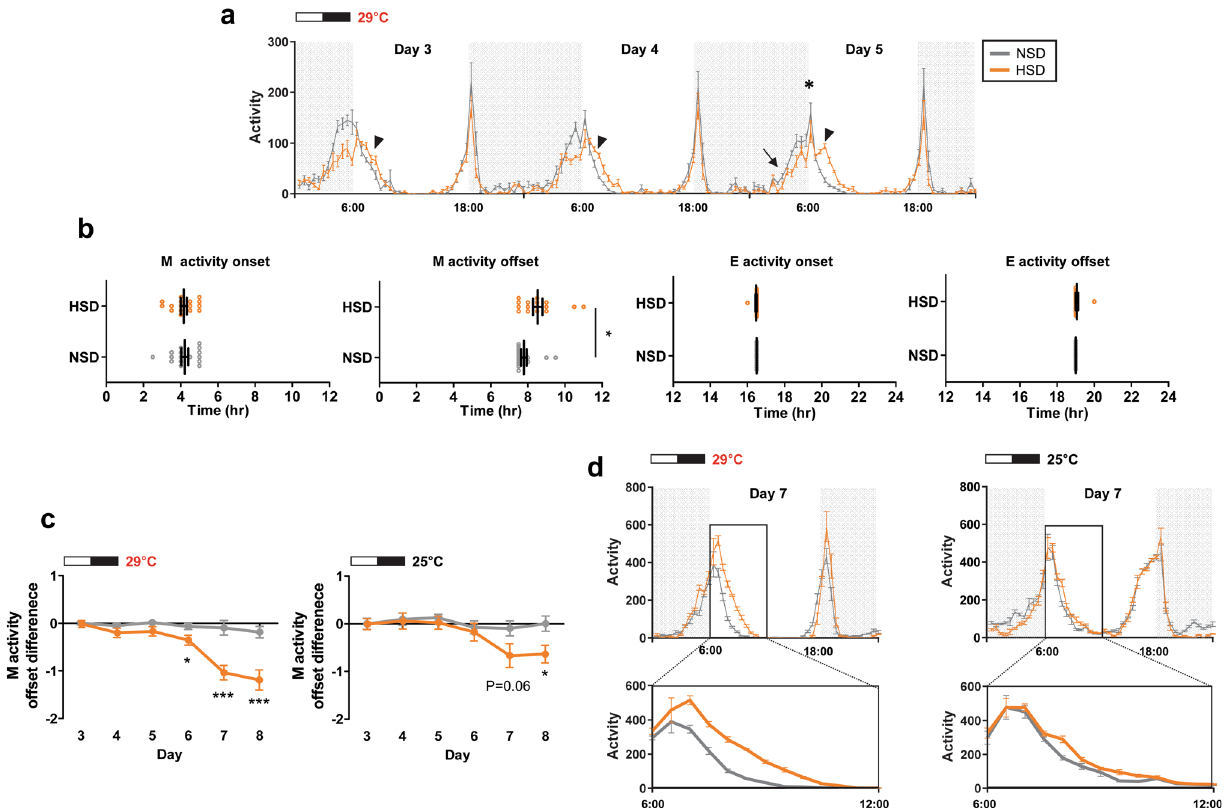
Fig. 1 Fly M activity but not E activity offset was extended in HSD. a , b w 1118 fl y locomotor activity was analyzed in normal sucrose diet (NSD) and high- sucrose diet (HSD) under a 12L:12D cycle at 29 °C. a Daily activity pro fi les from day 3 to day 5 are shown. Arrow indicates anticipatory activity and asterisk indicates the startle response. M activity, but not E activity, was extended in fl ies fed a HSD (arrowhead). b M and E activity onset and offset times for individual w 1118 fl ies on day 5 are shown. Bars indicate mean ± SEM values ( n = 28 – 31). Statistically signi fi cant differences in the onset or offset between NSD and HSD (independent t test): * P < 0.05. c , d w 1118 fl y locomotor activity was analyzed in NSD and HSD under 12L:12D cycle at 29 °C and 25 °C. Daily activity pro fi les for days 3 – 8 are in Supplementary Fig. 2. c M activity offsets of individual w 1118 fl ies were obtained and the differences versus day 3 are shown. The M activity offset in HSD was progressively delayed at 29 °C and 25 °C. Values indicate mean ± SEM ( n = 30 – 37). Statistically signi fi cant differences in the M activity offset between NSD and HSD at each day (independent t test): * P < 0.05; *** P < 0.001. d Daily activity pro fi les on day 7 at 29 °C and 25 °C are shown. Lower panels show a magni fi ed image of the boxed region in the upper panel. The extent of M activity offset delay was greater at 29 °C than at 25